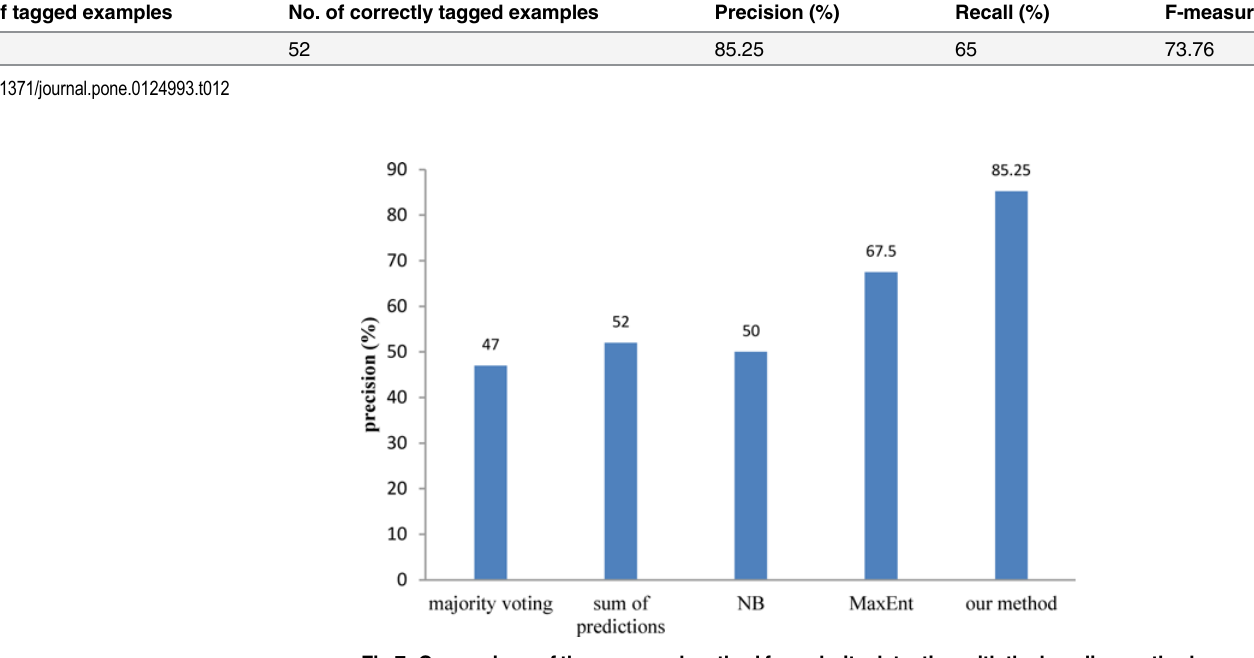
Fig 7. Comparison of the proposed method for polarity detection with the baseline methods